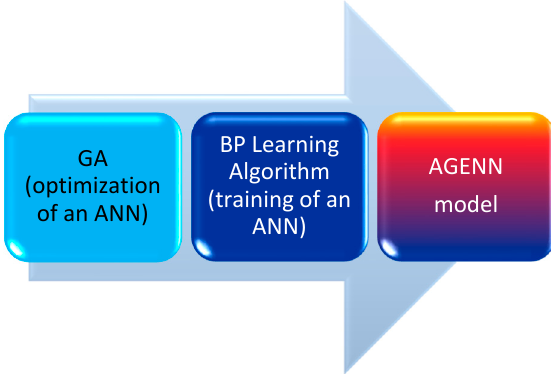
Figure 3. The model’s development procedure.